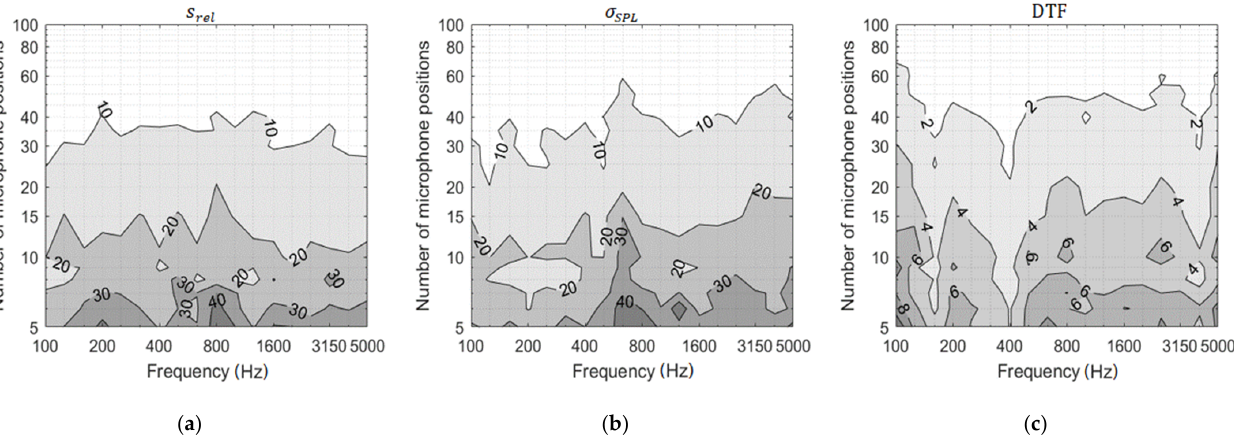
Figure 7. The coefficients of variation of diffuseness metrics: ( a ) s rel , ( b ) σ SPL and ( c ) DTF measured in the empty room as a function of frequency with an increased number of microphone positions.